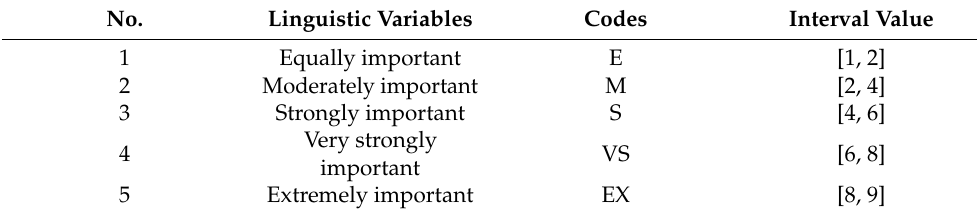
Table 2. Linguistic terms for pairwise comparison of RPN elements